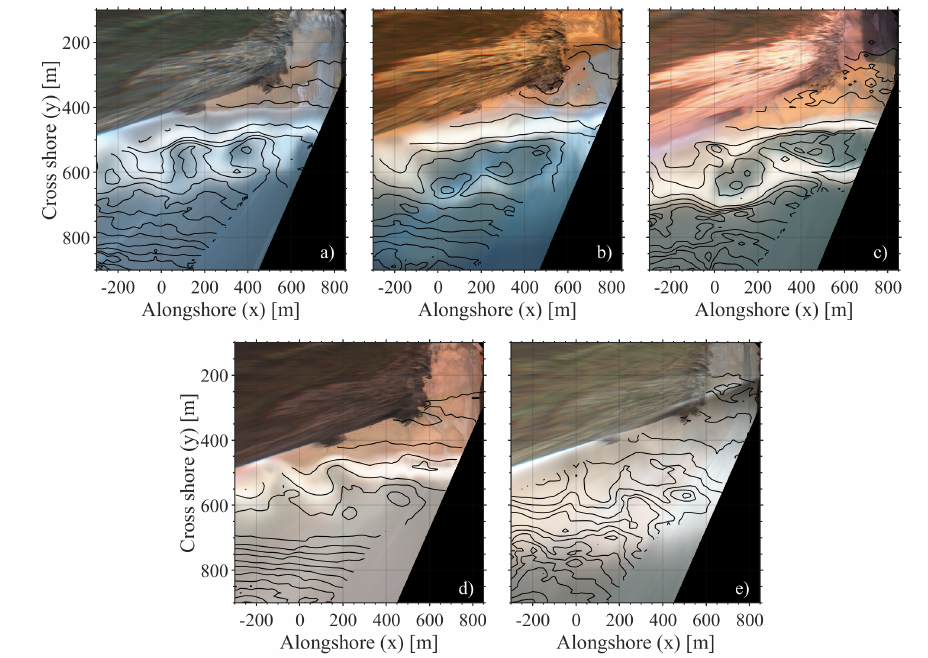
Figure 10. Traditional projected pixel intensity maps with overlaying video-derived bathymetry estimates (black-lines). Panel ( a ) represents the situation on 22 October 2013 and shows a transverse bar and rip beach state, ( b ) represents an “alongshore bar trough” beach state for the field of view on the 14 August 2014. Also in ( b ) there is a hint of bar welding around x = − 200 m indicating a TBR situation but in comparison to ( a ) with a larger alongshore wavelength. Panel ( c ) shows increased three-dimensionality. The bottom plots indicate the limitations of foam patterns. ( d ) highlights that during low-tide under low-energetic wave conditions the sub-tidal bar is invisible from pixel intensities. Alternatively, ( e ) represents a moment in time of high-tide and very energetic wave conditions resulting in a complete white surf zone and the sub-tidal bar is as well